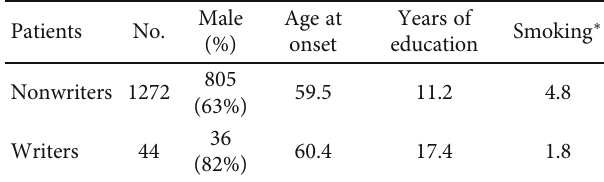
Table 1: Number of patients and writers.